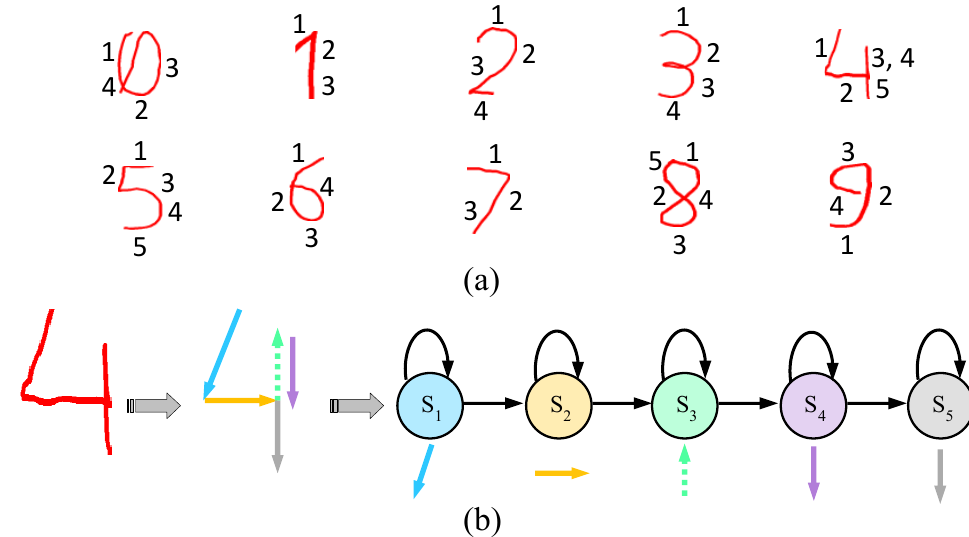
Figure 6. Straight-line segmentation with respect to number gestures 0–9: ( a ) segmentation parts for each gesture reference and ( b ) representation of gesture for ‘4’ using left–right banding with five segmented